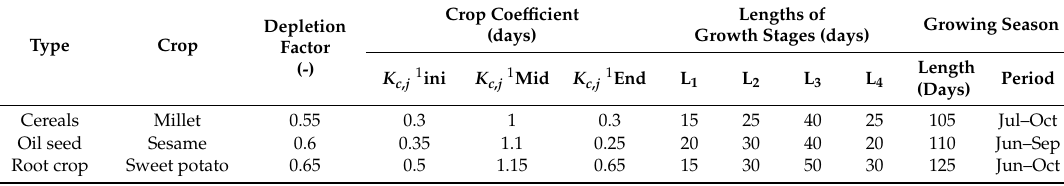
Table 4. Phenological parameters used to describe the growth stages of selected